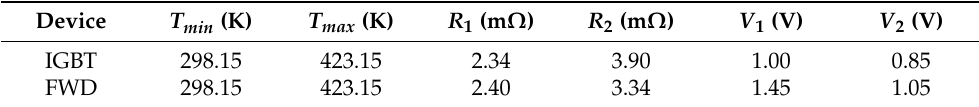
Table 4. Nominal values used in Equation